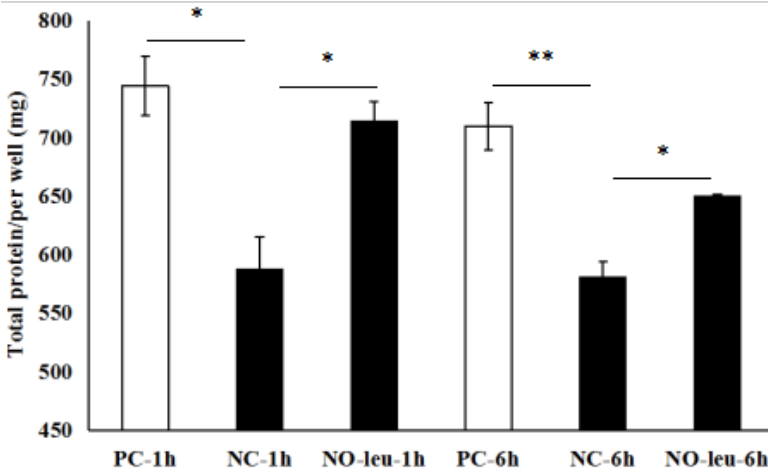
Figure 3. Effects of L -leucine limitations (1 h, 6 h) on total proteins content in mammary alveolar cells (MAC-T cells). NC: Negative control, Earle’s Balanced Salts Solution + insulin (5 μg/mL) + hydrocortisone (1 μg/mL) + prolactin (5 μg/mL); PC: Positive control, NC medium supplemented with 0.70 L -arginine, 0.15 L -histidine, 0.42 L -isoleucine, 0.45 L -leucine, 0.5 L -lysine, 0.12 L -methionine, 0.22 L -phenylalanine, 0.45 L -threonine, 0.04 L -tryptophan, and 0.45 L -valine (all in mmol/L); NO-leu: PC media devoid of L -leucine. * p < 0.05, ** p < 0.01.